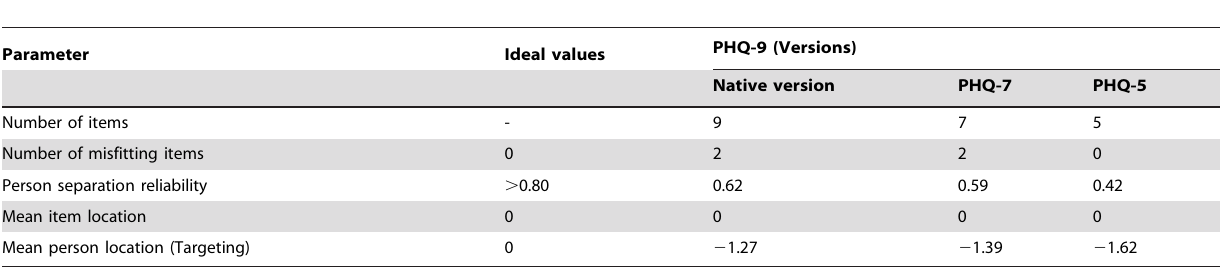
Table 3. Summary of the overall performance of the Patient-Health Questionnaire-9.